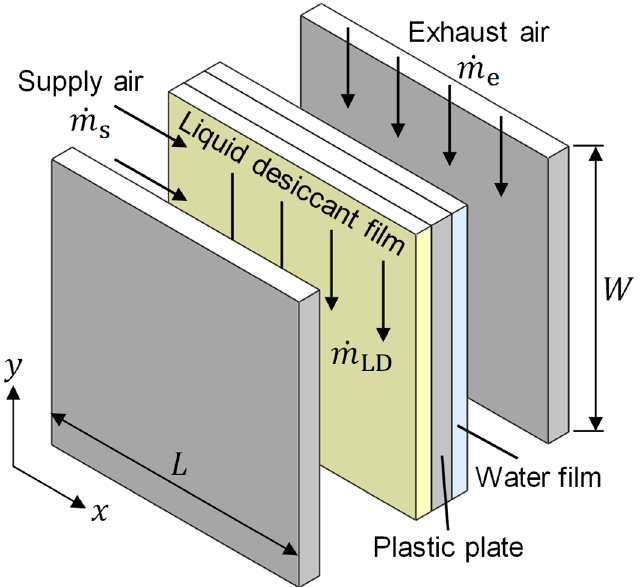
Figure 2. Schematic of the dehumidifier used to develop the heat and mass transfer model.